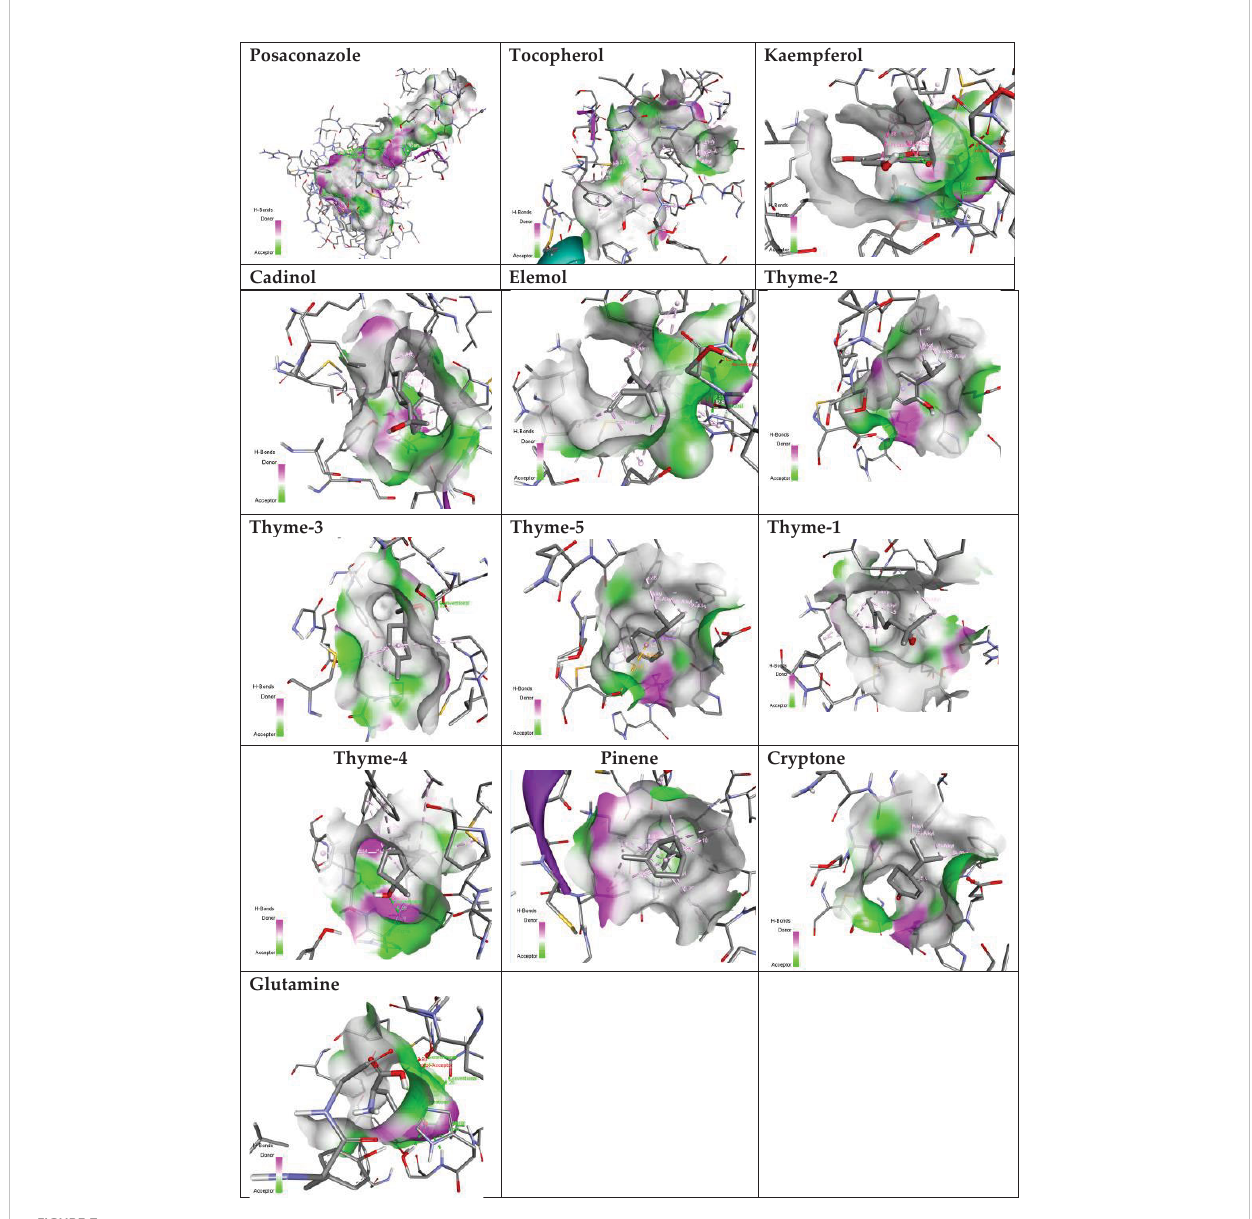
the stable complex (Figure S8). As expected, very low charge bonds are formed between the ligands and the receptors since the reactions relied mostly on hydrophobic interactions leading to the formation of neutral interfaces (Figure S9). The hydrogen bond formation was observed in the cases of kaempferol, cryptone, thyme-3,4, and glutamine, which are shown in the hydrogen bond donor/ acceptor surface view in Figure S10. The stable ligand conformation was increased due to the formation of multiple chemical bonds with many atoms of the ligand that hold the ligand steady and make it more stable in the binding site. This was highly observed in tocopherol, cadinol, and elemol (Figures 9,